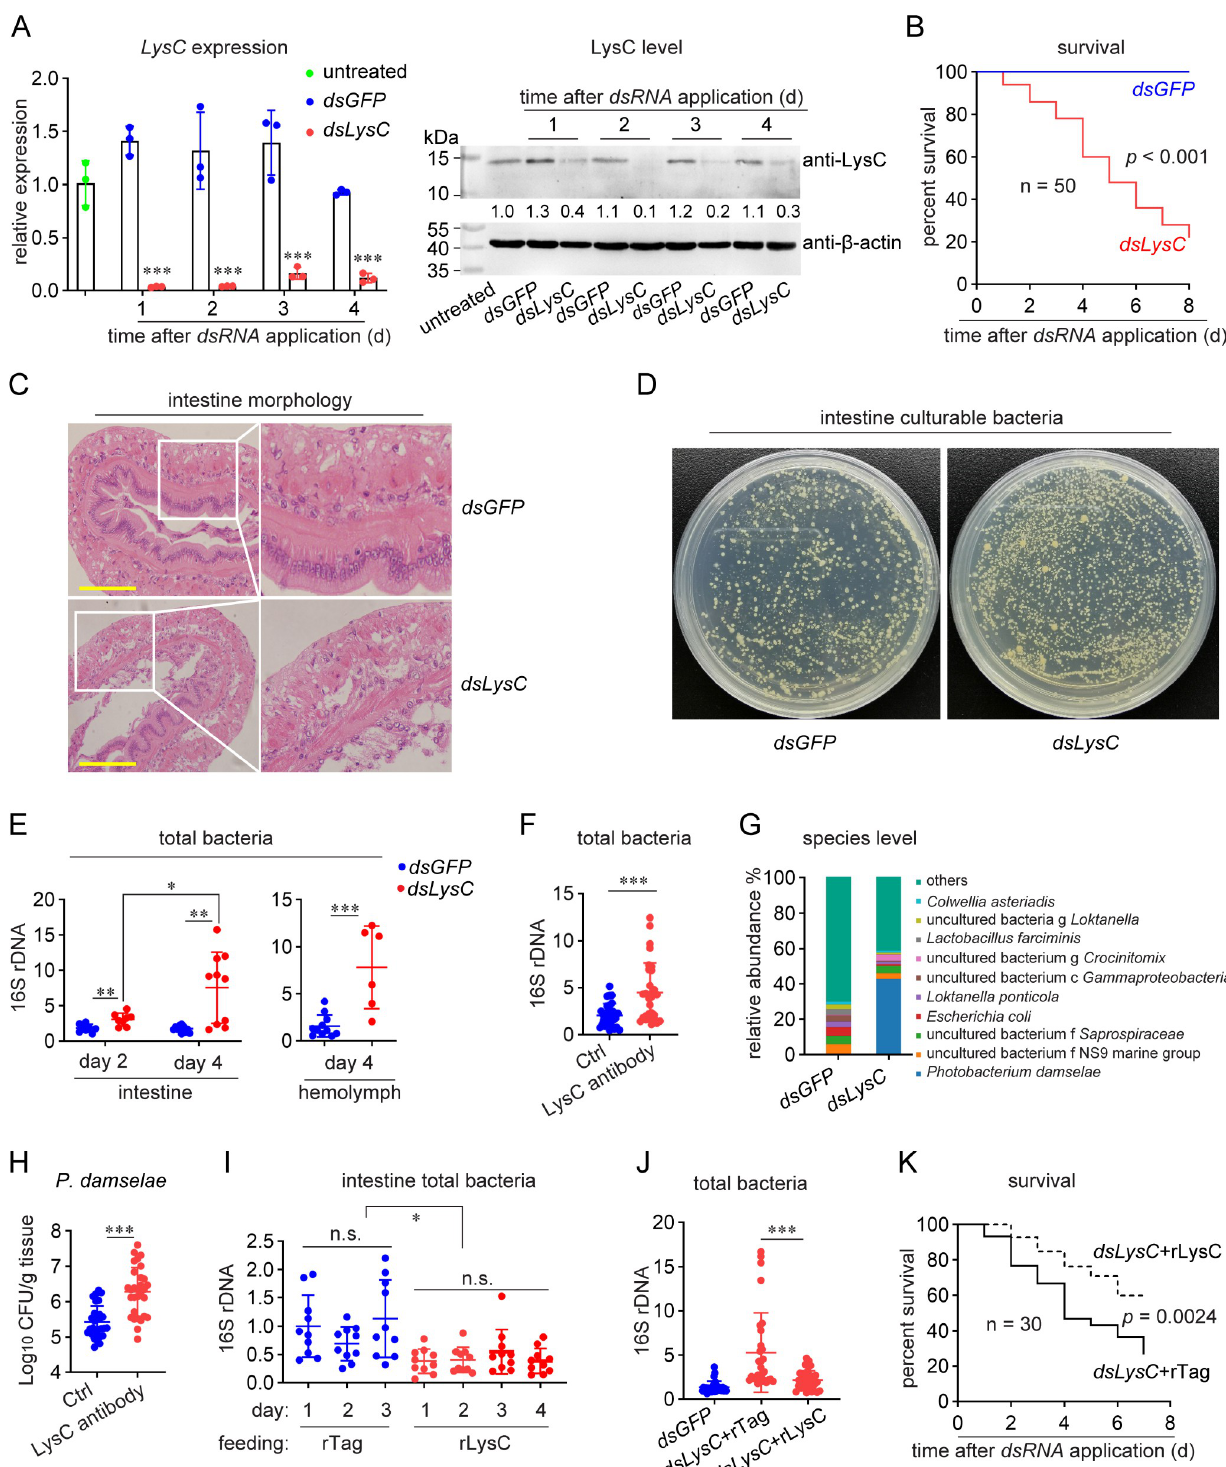
Fig 2. Functions of LysC in maintaining intestinal microbiota homeostasis. (A) RNAi efficiency of LysC as determined using qRT-PCR or western blotting. dsRNA was injected into shrimp (5 μ g/g body weight). LysC mRNA expression and protein level in intestine was detected at indicated time. Bar chart shows the mean ± SD from three replicates, and the blotting images are representative of three independent replicates. Gray values were analyzed using ImageJ software. Each sample originated from five shrimp. (B) Shrimp mortality analysis after LysC knockdown. Shrimp death was recorded each